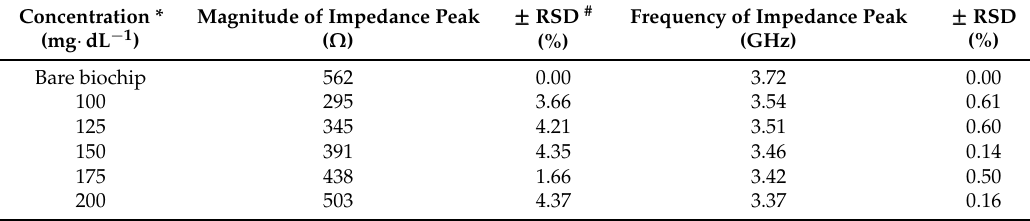
Table 1. Variation in magnitude and shift of frequency of the biochip’s characteristic impedance at its resonance for serum samples of varying glucose